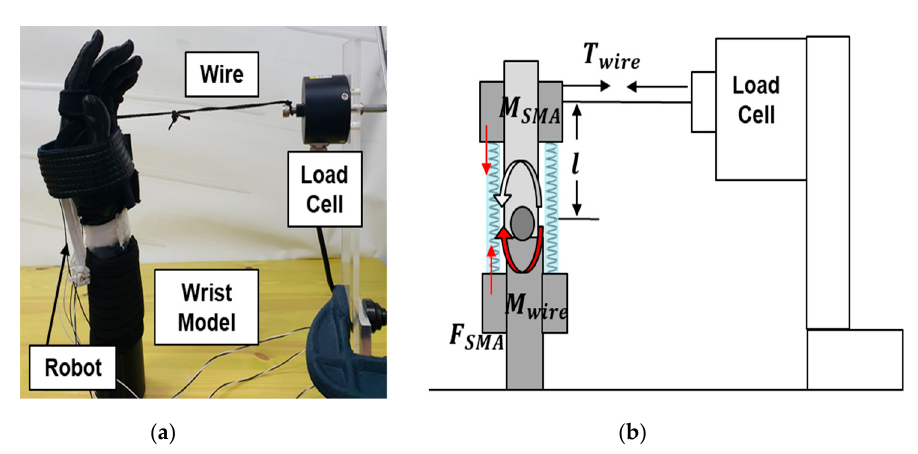
Figure 9. Experimental setup for torque measurement of SWA, ( a ) experimental setup for measuring extension torque, ( b ) schematic of torque measurement system.